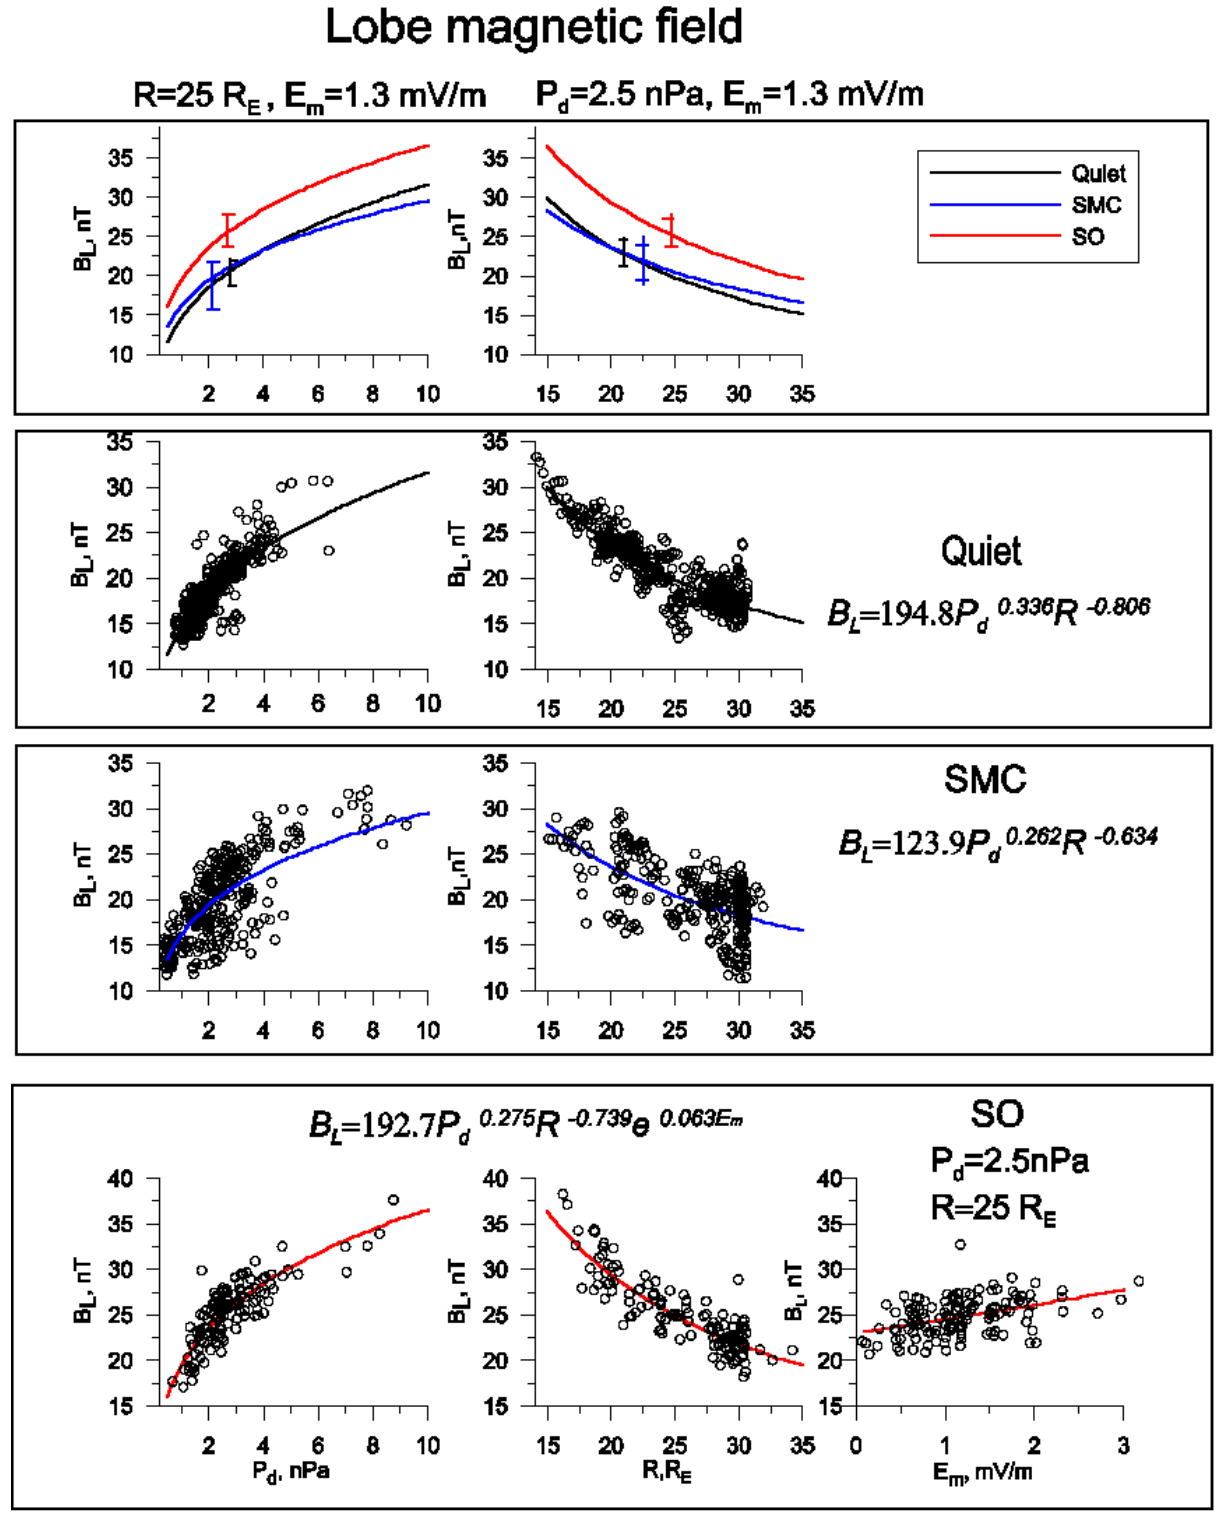
Fig. 3. The B L -dependence on P d (left panel), on R (central panel), and on E m (for SO, left panel) for three magnetospheric states discussed. The experimental points are reduced, every tenth point, every fifth point and all points being shown for Q, SMC and SO